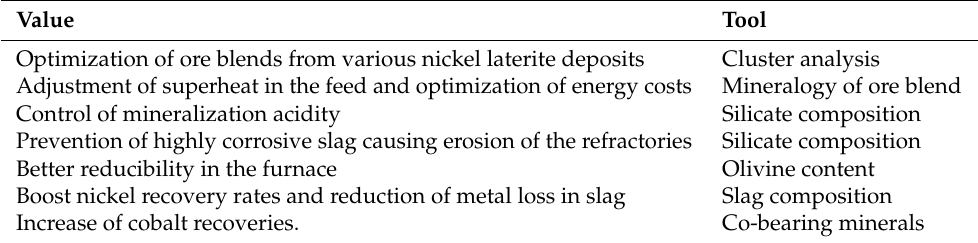
Table 5. Value and parameter to increase the profitability of nickel laterite processing. Value Tool Optimization of ore blends from various nickel laterite deposits Adjustment of superheat in the feed and optimization of energy